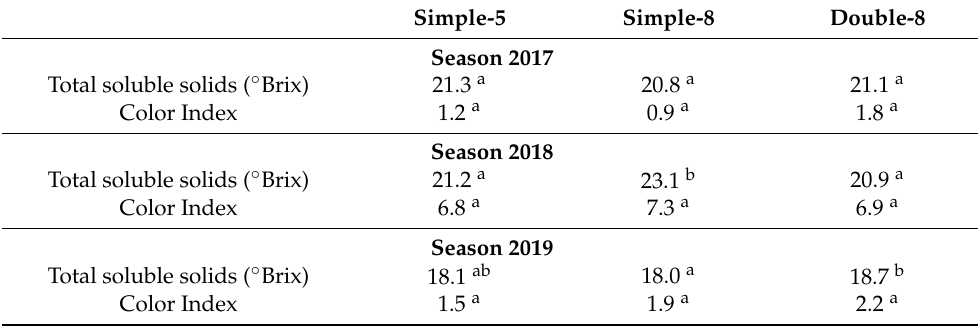
Table 9. Effects of the different irrigation regimes carried out in the persimmon trial on fruit compo- sition. Within each row, different letters indicate significant differences between